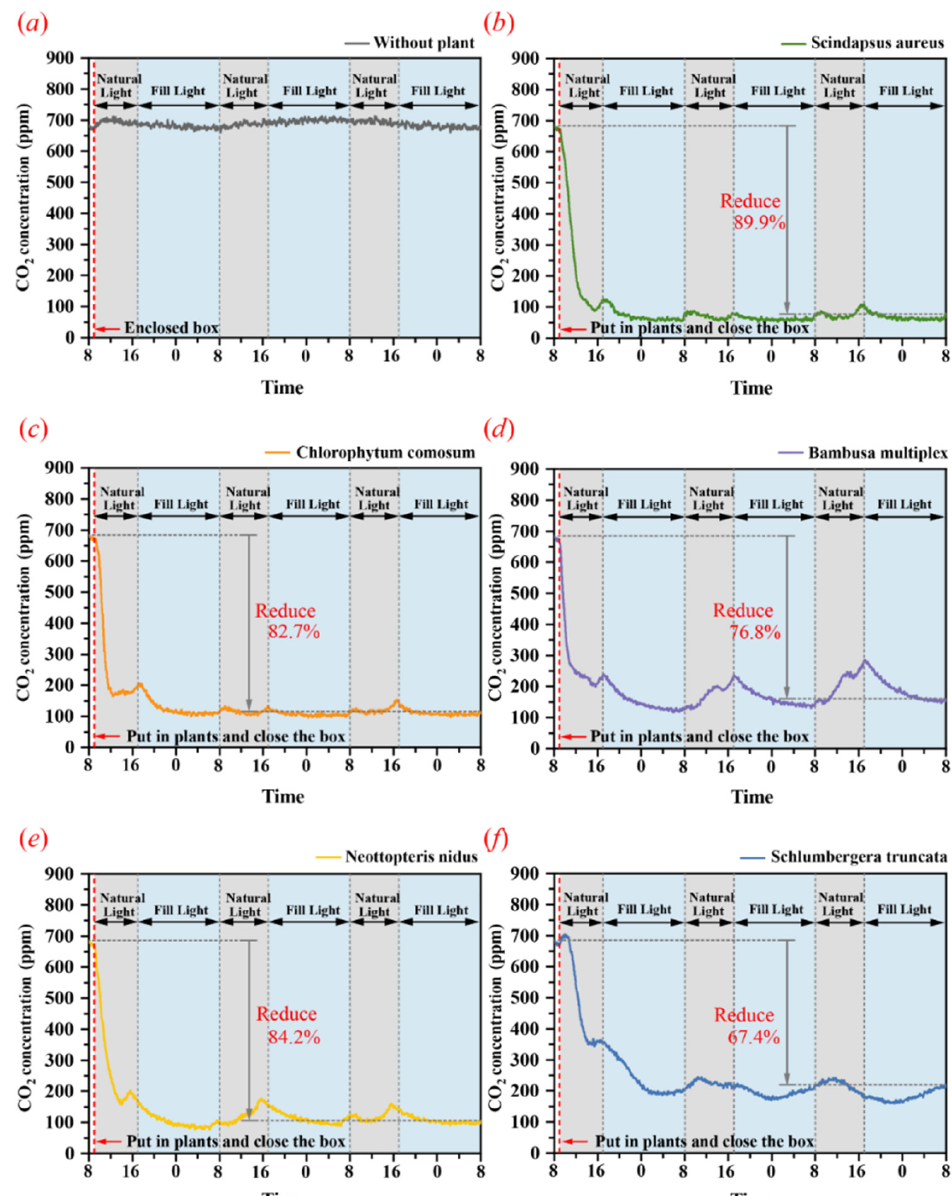
Figure 5. Fluctuation of CO 2 concentration in six sealed chambers in the all-day lighting environment. ( a ) without plant ( b ) Scindapsus aureus ( c ) Chlorophytum comosum ( d ) Bambusa multiplex ( e ) Neottopteris nidus and ( f ) Schlumbergera truncate .